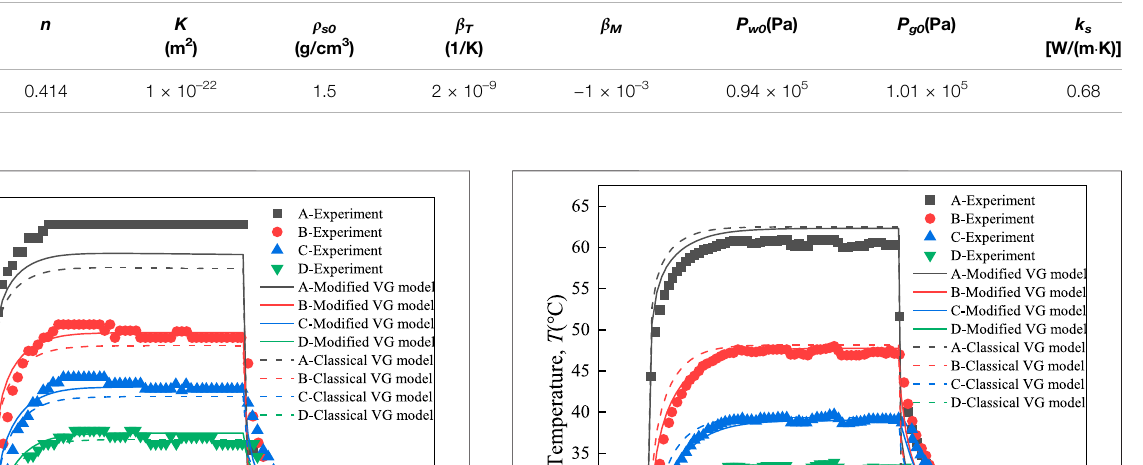
TABLE 2 | Physical parameters of soil sample.